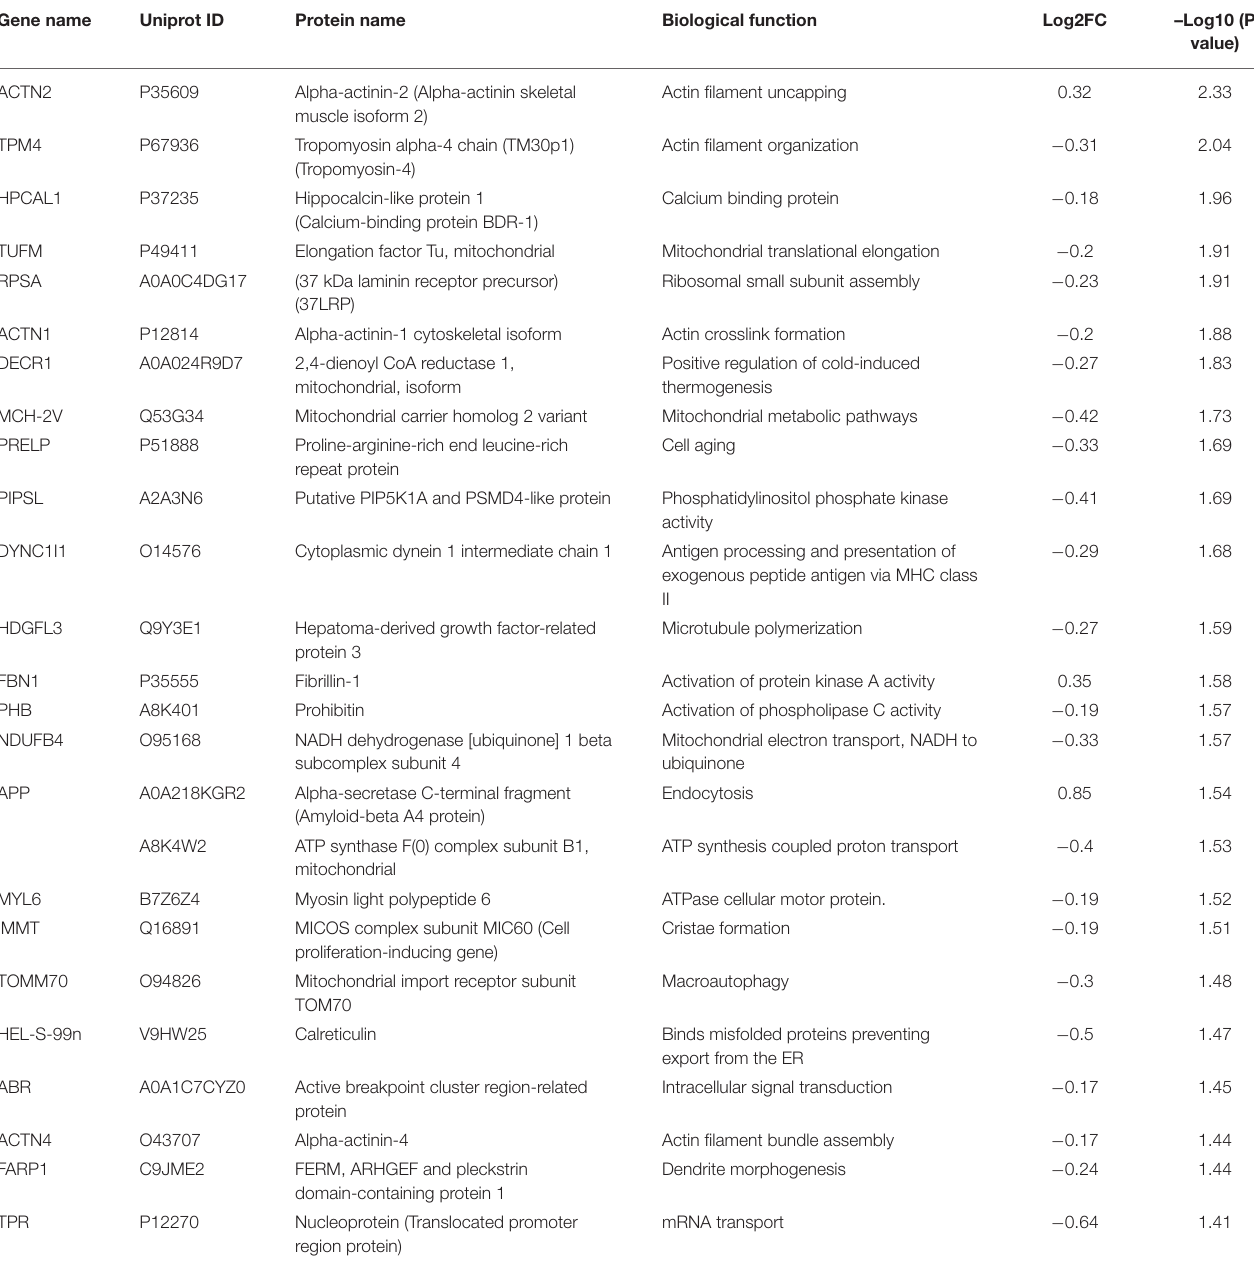
TABLE 3 | List of Top 25 proteins significantly regulated in the inferior frontal gyrus cerebrovasculature of low CAA vs. aged-matched control